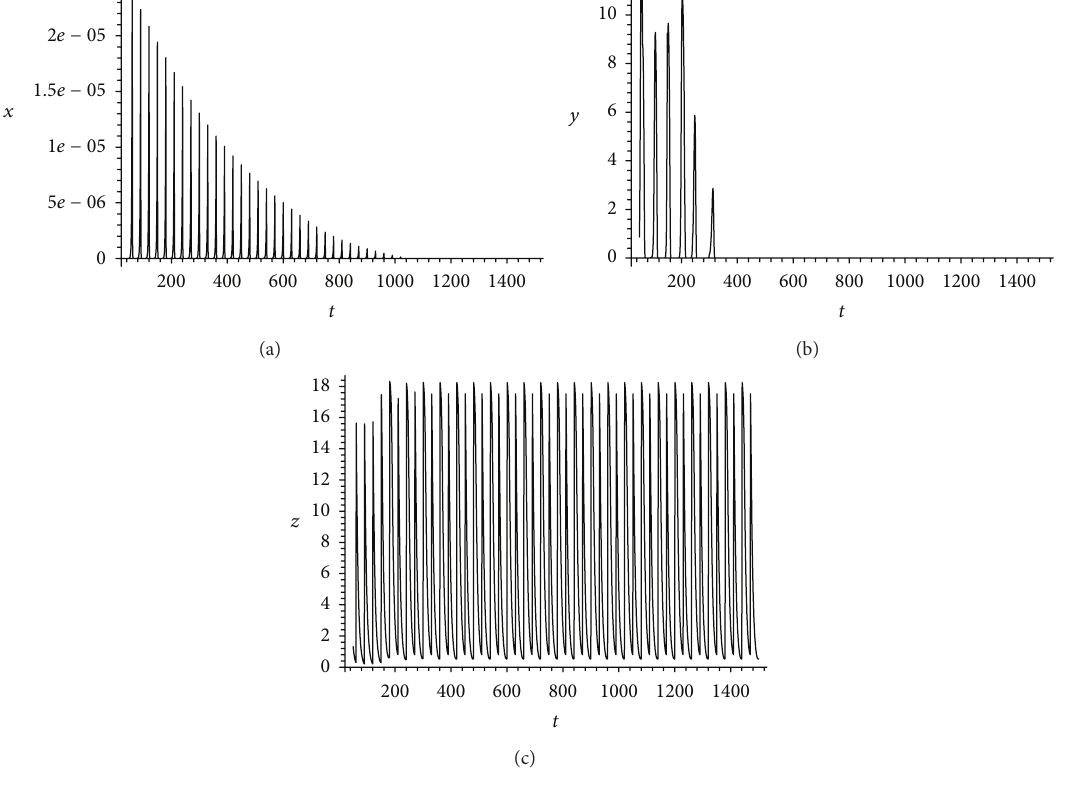
Figure 2: The dynamics of the system